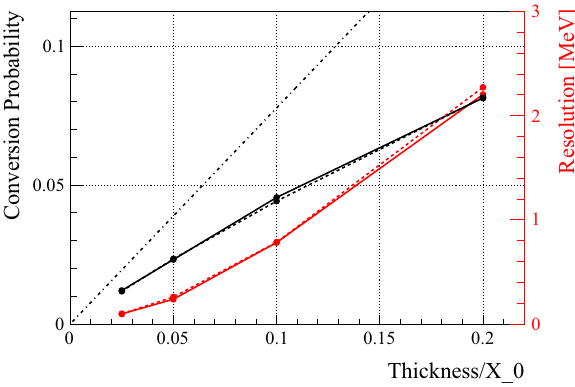
Fig. 3 The conversion efficiency (black, left axis) and the contribution to the energy resolution from the energy loss in the converter (red, right axis), for Lead (full lines) and Tungsten (dashed lines), as a function of the converter thickness (in units of radiation length). The dash-dotted line shows the asymptotic conversion probability, 7 / 9 times the thick- ness in units of radiation